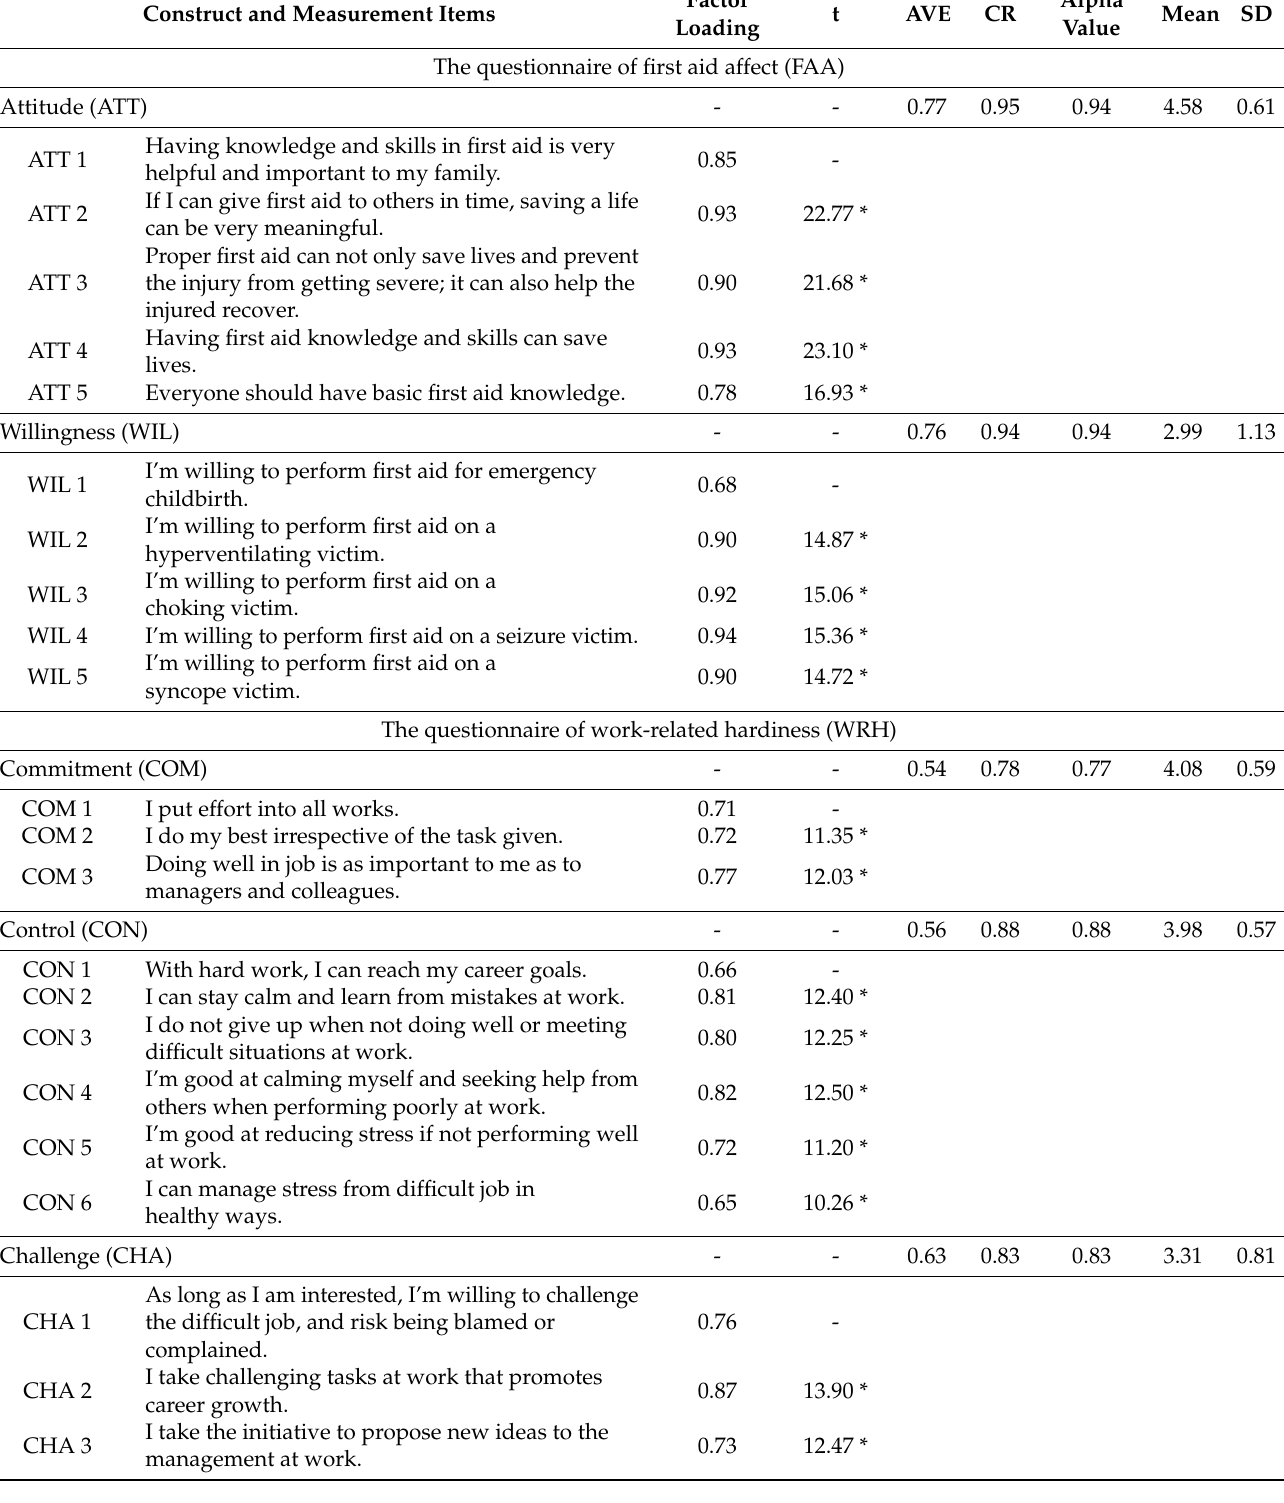
Table 4. The CFA analysis of the three separate questionnaires (FAA, WRH and SEFA) ( N = 318). Construct and Measurement